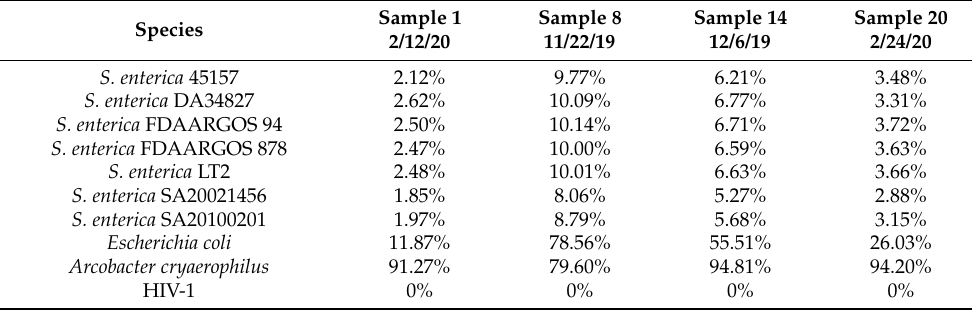
Table 3. Percent Breadth of Coverage on Stewart’s Drain